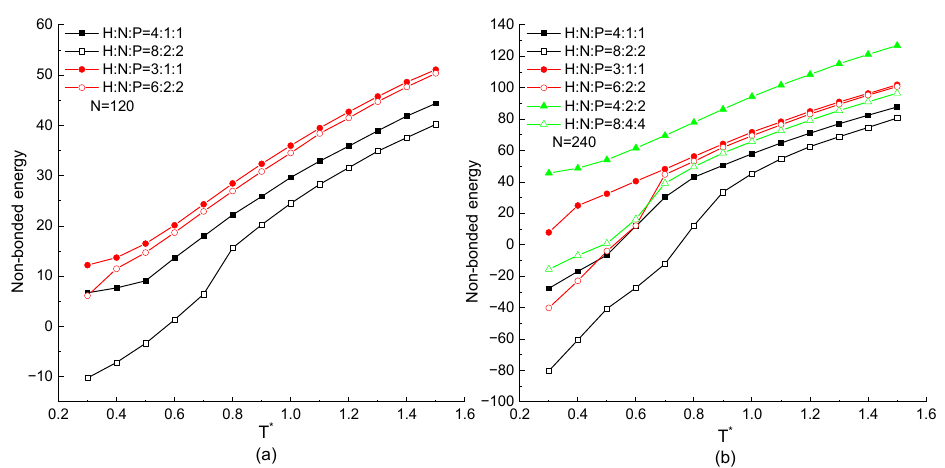
Figure 7. The non-bonded energy versus reduced temperature T ∗ of different ratio and serial number of H, N, and P residues with protein chain length ( a ) N = 120, ( b ) N = 240.